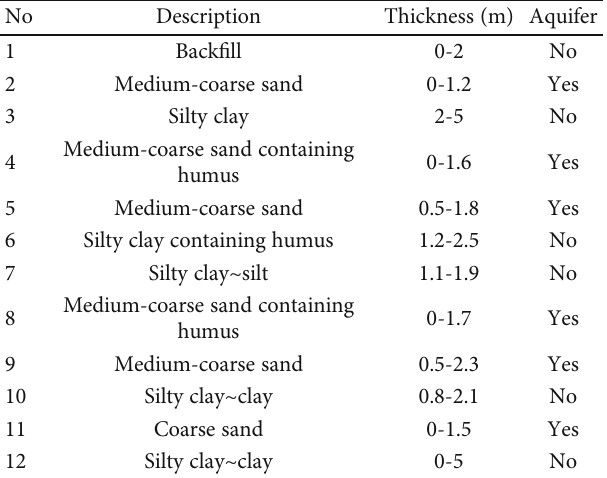
Table 1: Thickness of each layer in the Quaternary system of Qingdao area.